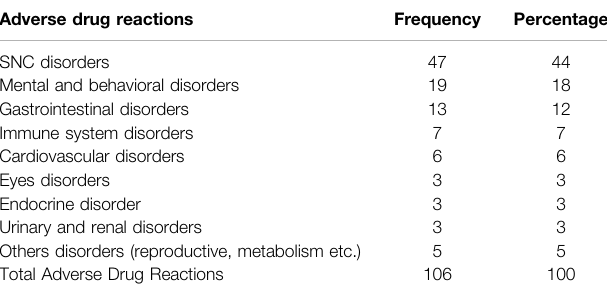
TABLE 6 | Distribution of Adverse Drug Reactions reported by MedDRA System Organ Classes